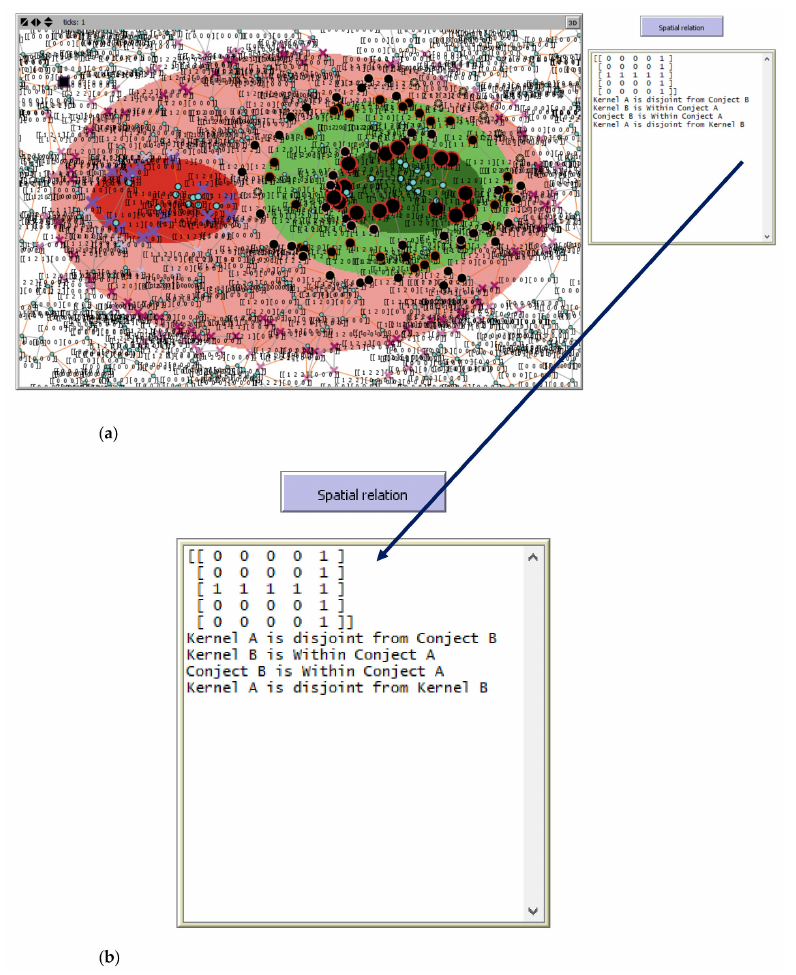
Figure 8. ( a ) The SN showing sensor spatial states as the sensor label after boundary detection and intersection analysis and ( b ) enlargement of the output showing resulting I 5 × 5 M and explicit describing the fuzzy spatial